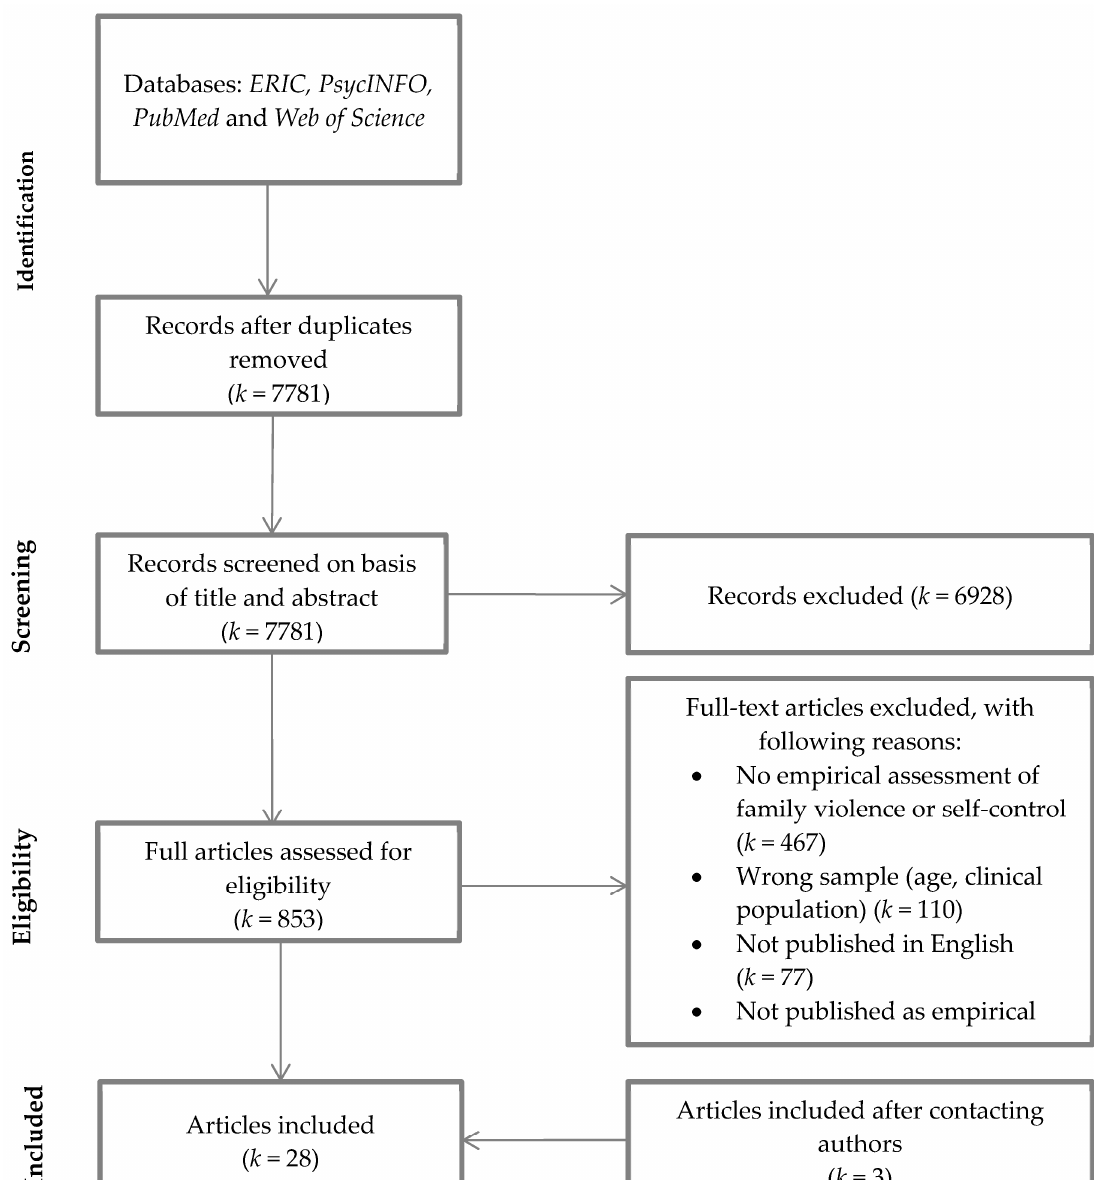
Figure 1. PRISMA flowchart used to identify studies for detailed analysis of family violence and self-control.